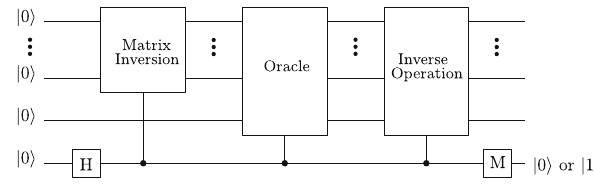
Fig. 3 Scheme of quantum circuit implementing the SVM method